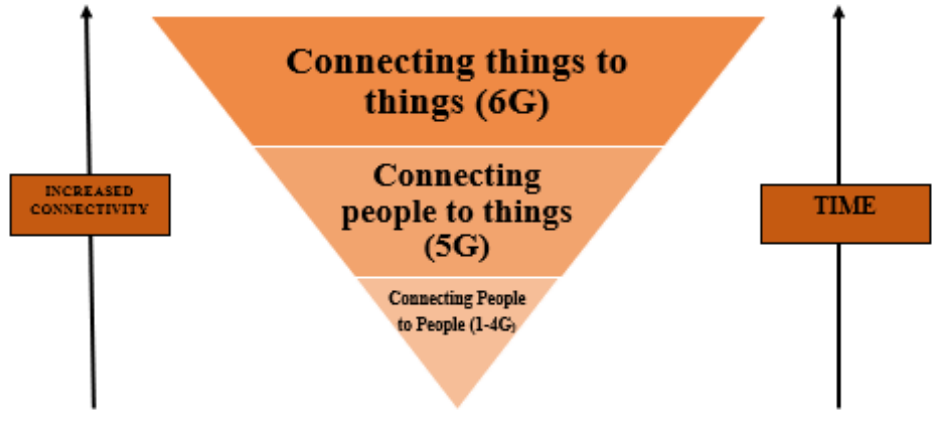
Figure 2. Evolution of Internet.